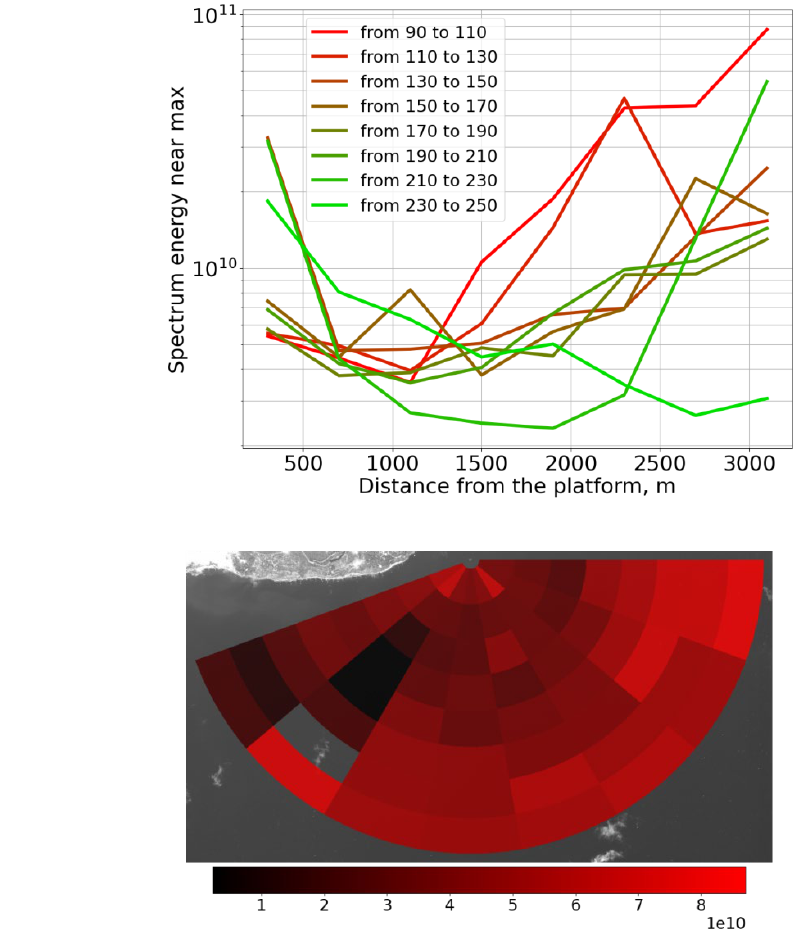
Figure 13. Dependence of integral energy of the wave spectrum near the spectral maximum (fre- quency 0.2–0.4 Hz) on the direction and distance to the platform. ( a ) One-dimensional plots along selected directions; ( b ) two-dimensional polar diagram.